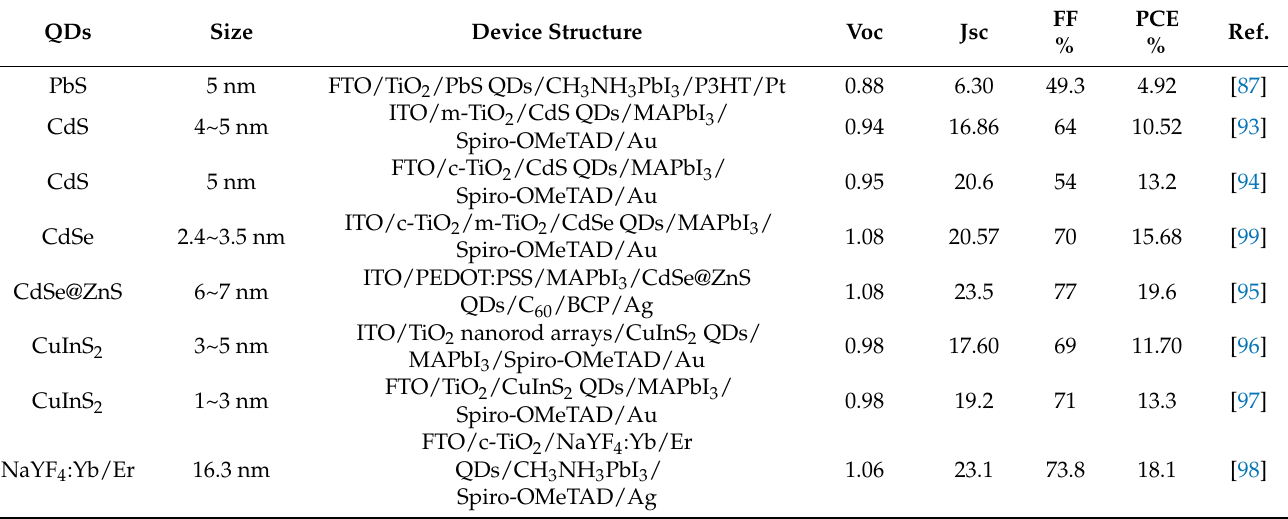
Table 3. Details of other QDs as the perovskite/ETL interface layer.